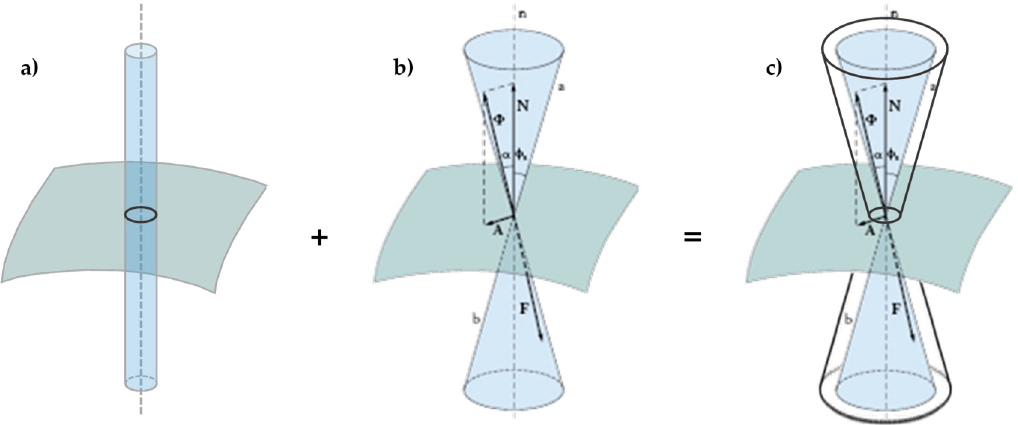
Figure 21. Limit surfaces in static conditions: ( a ) limit surface of the chemical bond, with the shear forces that determine the limit condition, independently of the compression forces, ( b ) cone of static friction, and ( c ) cone of cohesive static friction, which results from the combination between the limit surface of the chemical bond and the cone of static friction.